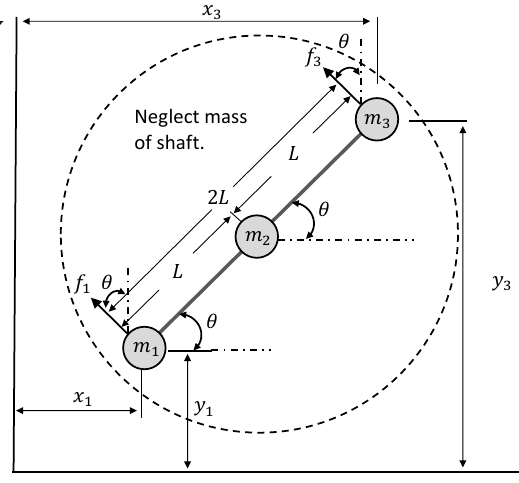
Figure 1. Underactuated robot as a system of